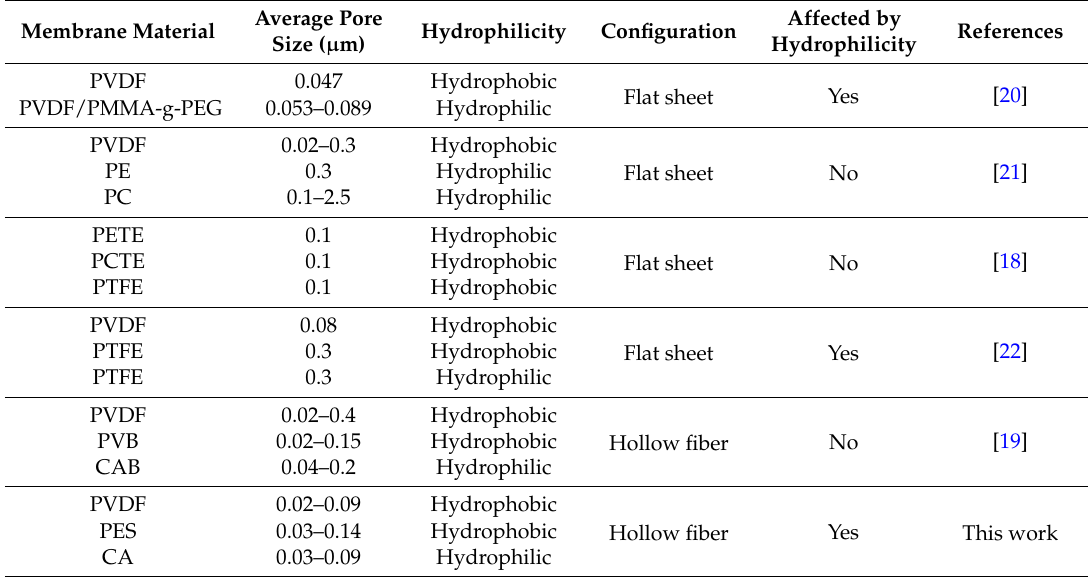
Table 1. Membrane properties used in previous work and claims regarding the effect of membrane surface hydrophilicity on